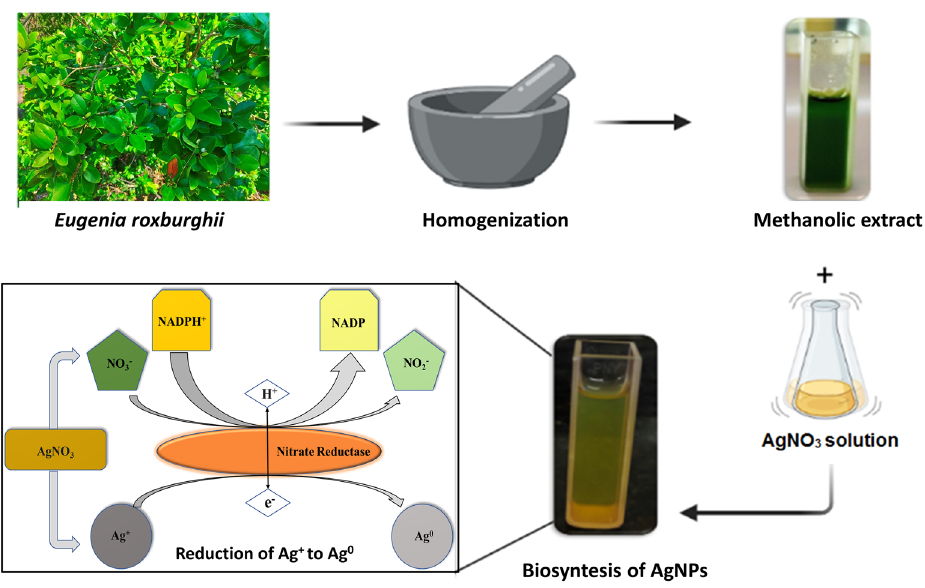
Figure 7. Synthesis of AgNPs from E. roxburghii leaf